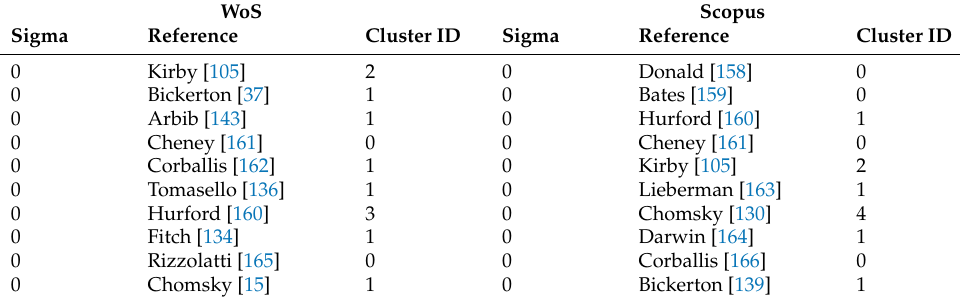
Table 8. Sigma indicator of biolinguistics by references using scientometric